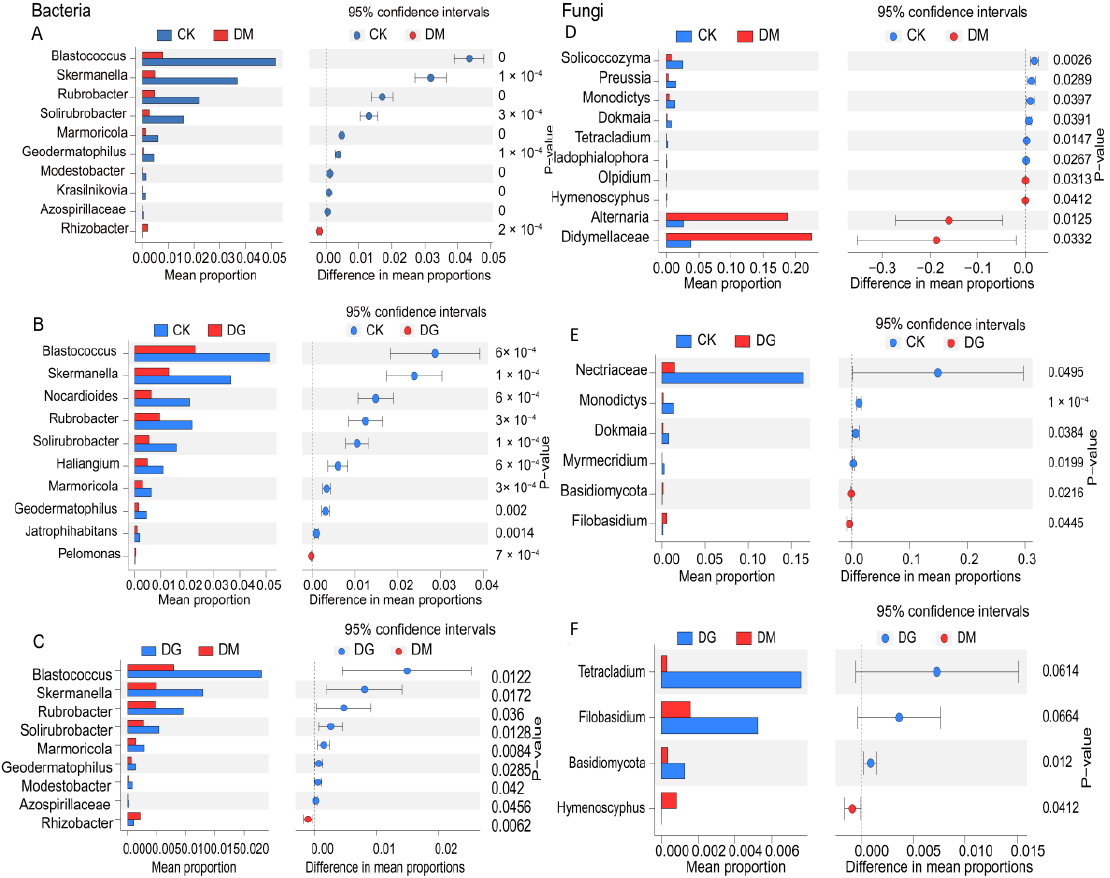
Figure 5. STAMP analysis of different soil samples with differing taxa (95% confidence intervals, p < 0.05). Bacteria ( A , B ) and fungi ( D , E ) indicate significant responses of genera between CK and DM and between CK and DG, and bacteria ( C ) and fungi ( F ) indicate significant responses of differential genera ( A – D ) between DM and